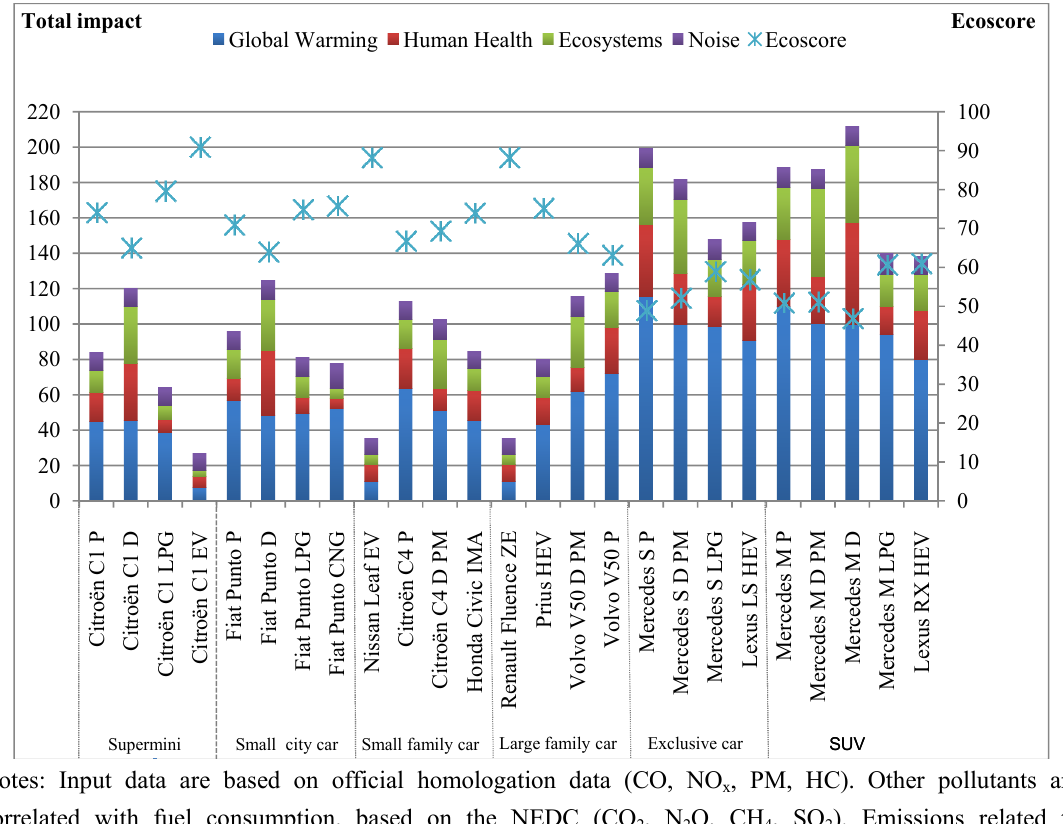
Figure 5. Total impact of the vehicle, split up per damage